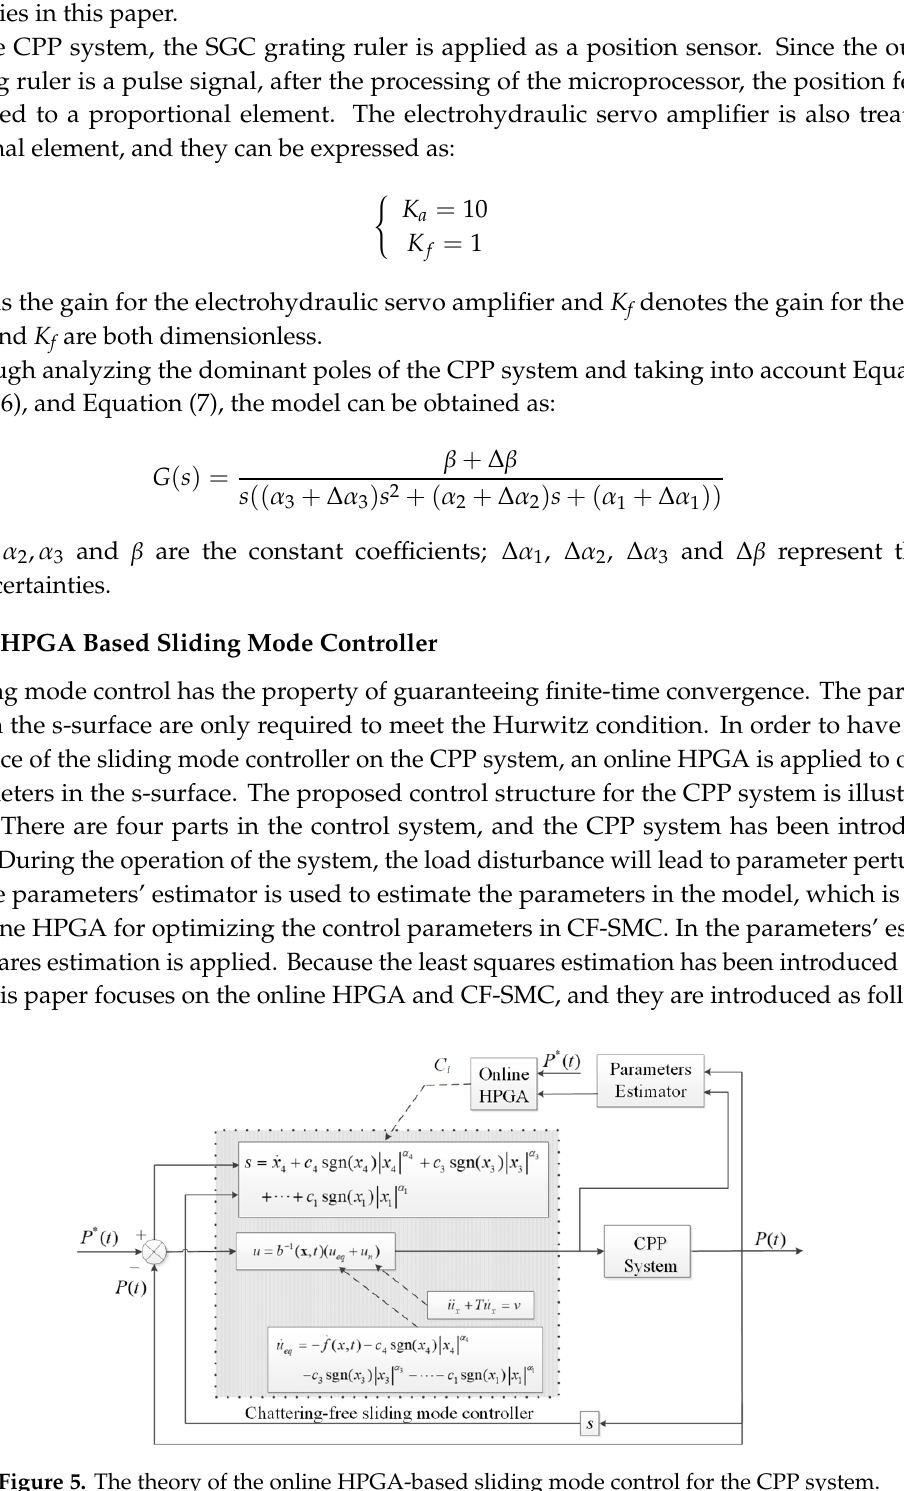
Figure 5. The theory of the online HPGA-based sliding mode control for the CPP system.